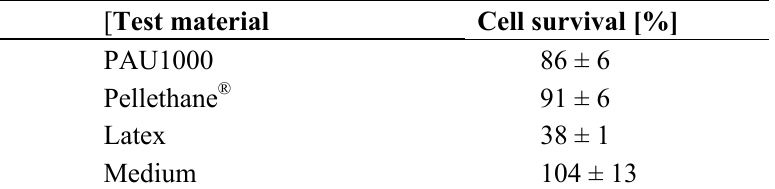
Table 2. Cytotoxicity determination. Cytotoxicity of PAU1000 was comparable to clinical grade polyurethane Pellethane ® . Controls were Latex (cytotoxic) and medium (non-toxic) (n = 4, data expressed as average ±